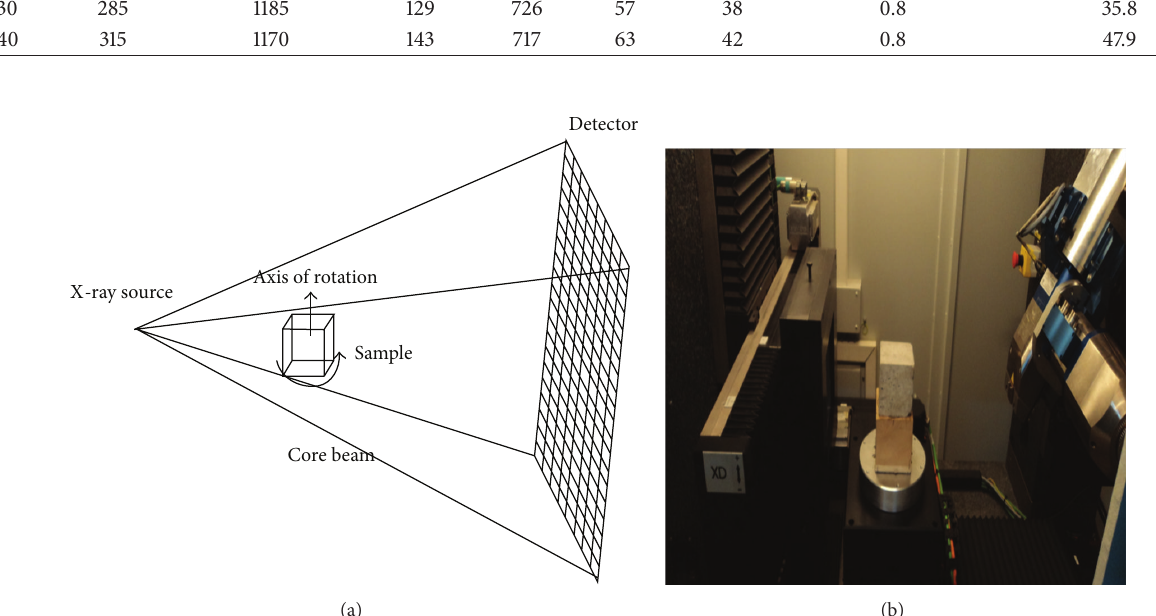
Figure 1: (a) Basic principle with cone beam and muhidetector for CT scanner. (b) Micro-CT scanning